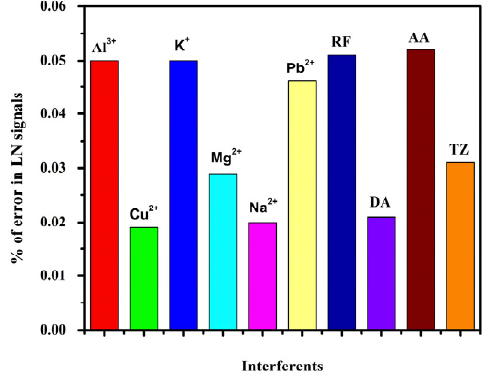
Figure 9. Plot of interferents vs. % of error in LN signal and cyclic voltammograms of different metal ions in the presence of LN.